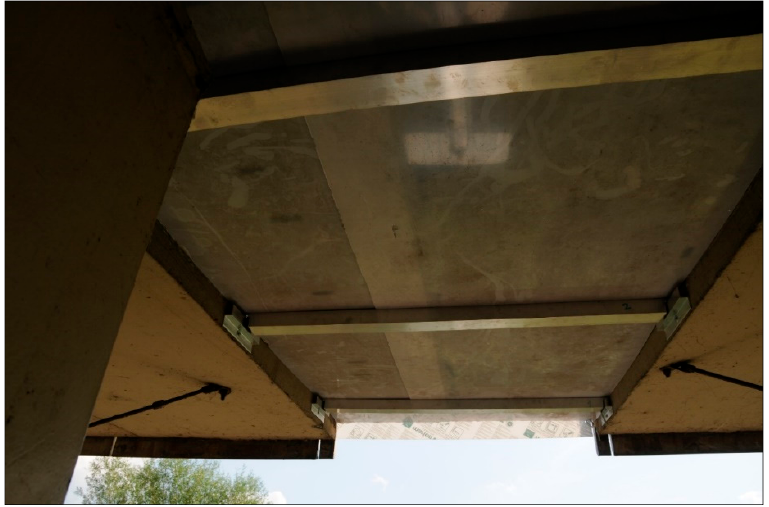
Figure 6. View of the solid polycarbonate plates mounted on the supporting structure of the acoustic cover.